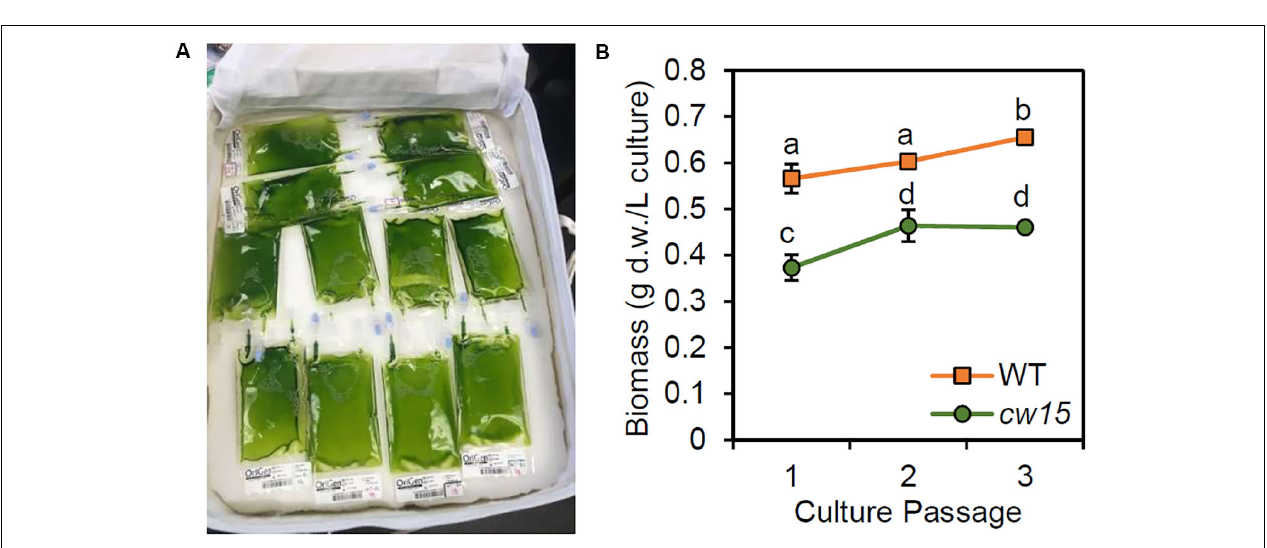
FIGURE 3 | (A) Storage of live algae cultures in CTB soft stowage bag. (B) Biomass yield after dark storage. Average and standard deviation of three biological replicates are plotted. Lowercase letters indicate statistically significant groups of culture passages based on ANOVA of each strain and a Tukey HSD test.